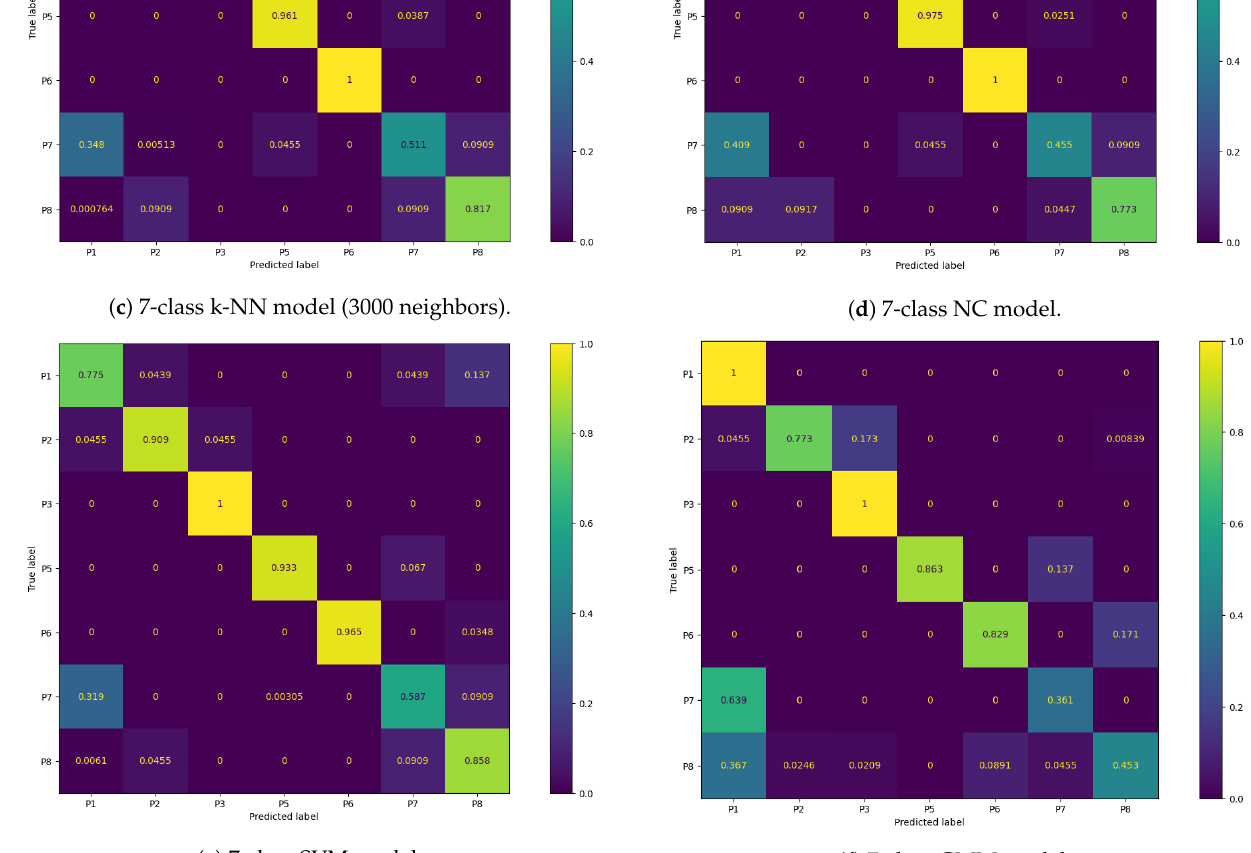
Figure A6. Confusion matrix of the classification results for each classifier (2nd